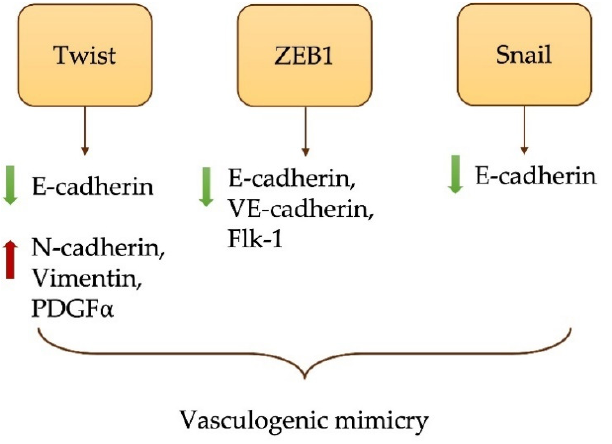
Figure 2. Correlation between EMT induction and VM.